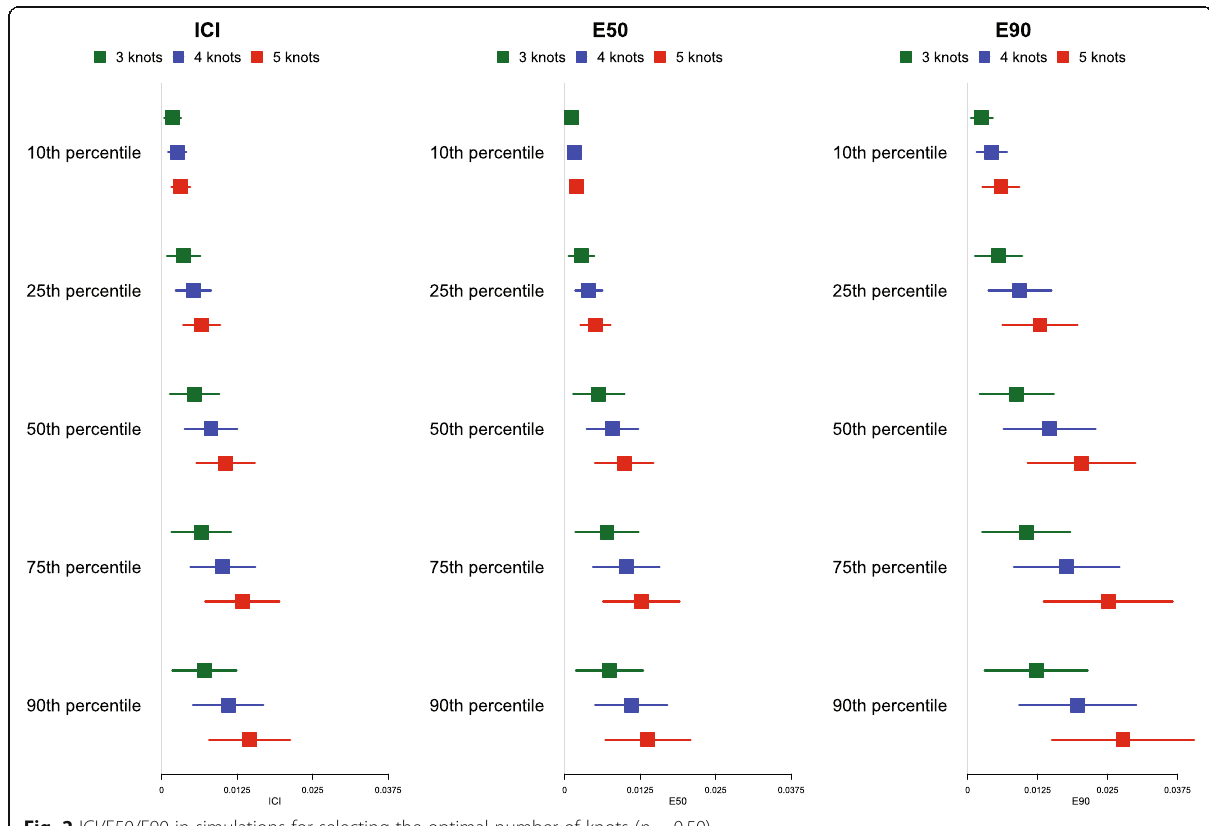
Fig. 2 ICI/E50/E90 in simulations for selecting the optimal number of knots ( p =